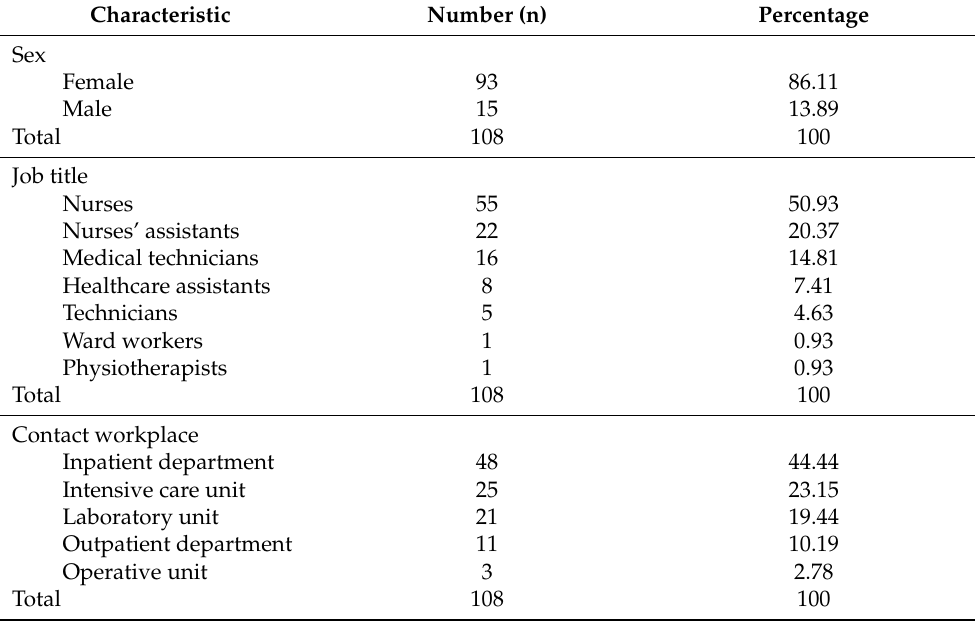
Table 1. Demographic data of